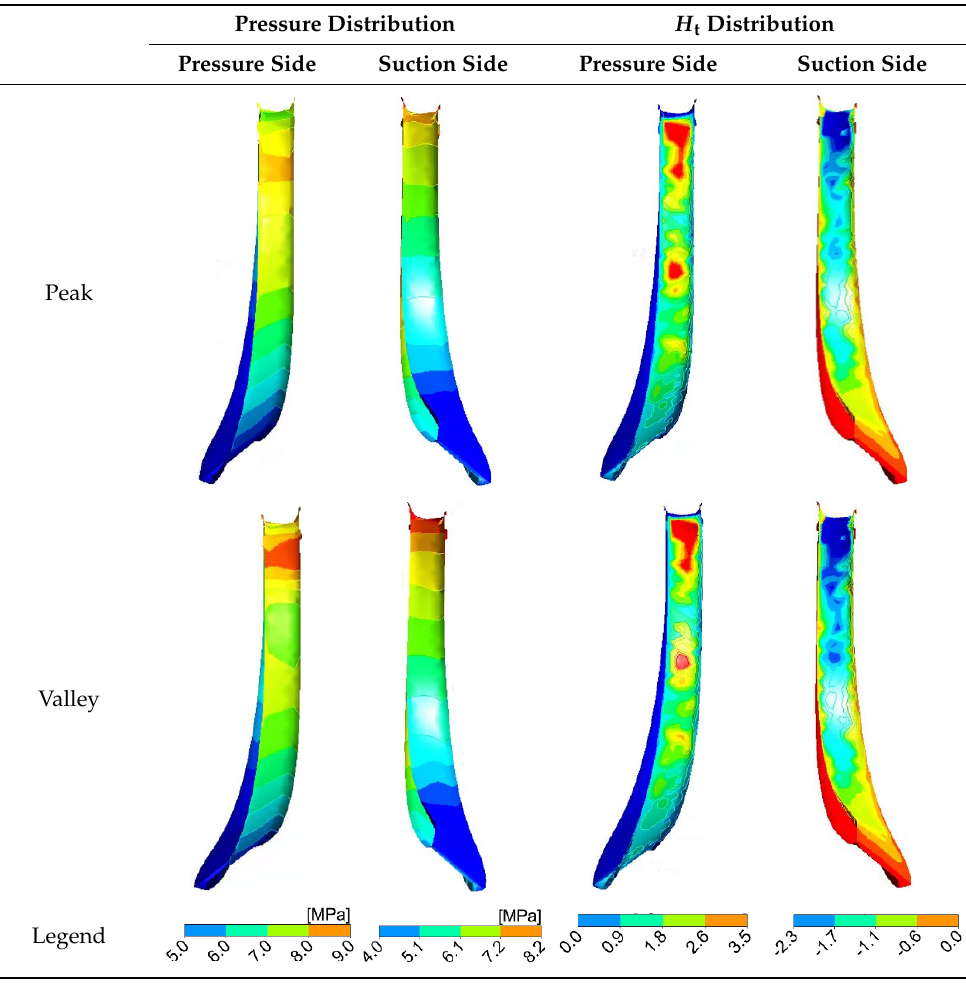
Table 3. Comparison of the capacity for work of the No. 6 blade.